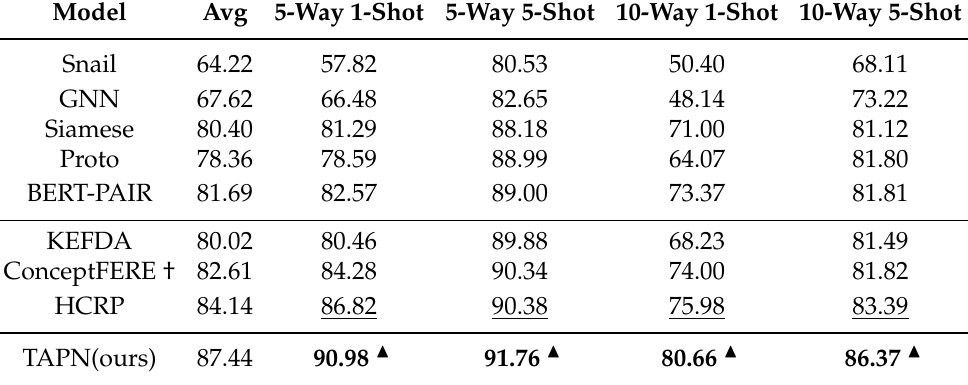
Table 4. Overall performance of our proposal and baselines in terms of average accuracy(%) on four typical meta-tasks. The results of the best baseline and the best performer in each column are underlined and boldfaced, respectively. Statistical significance of pairwise differences of the best baseline against our proposed TAPN is determined via a t -test ( quoted from the original published